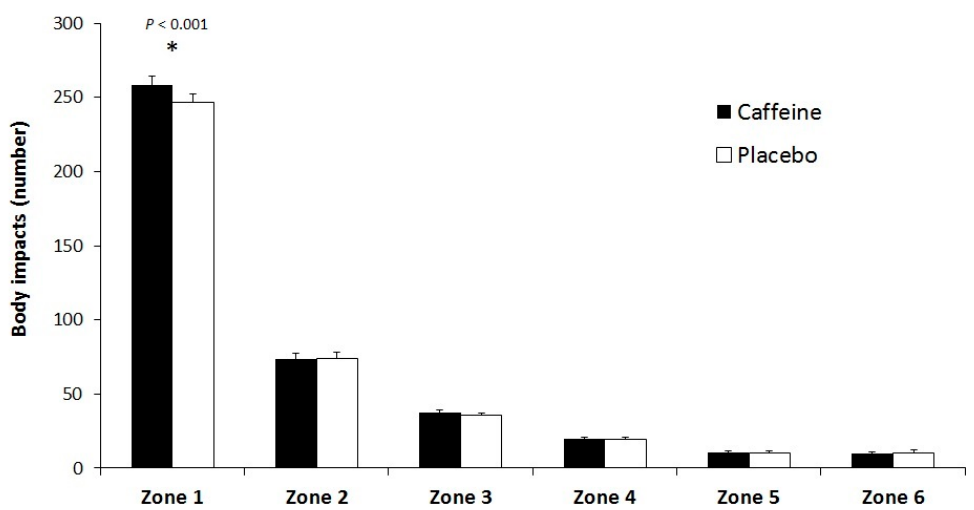
Figure 2. Number of impacts per minute during a simulated basketball game with the ingestion of caffeine (3 mg of caffeine per kg of body mass) or a placebo. Data are mean ± standard deviation for 20 basketball players. Zone 1 ≤ 0.99 G; Zone 2 from 1.00 to ≤ 1.99 G; Zone 3 from 2.00 to ≤ 2.99 G; Zone 4 from 3.00 to ≤ 3.99 G; Zone 5 from 4.00 to ≤ 4.99 G; Zone 6 ≥ 5.00 G. (*) Different from placebo ( p < 0.05).